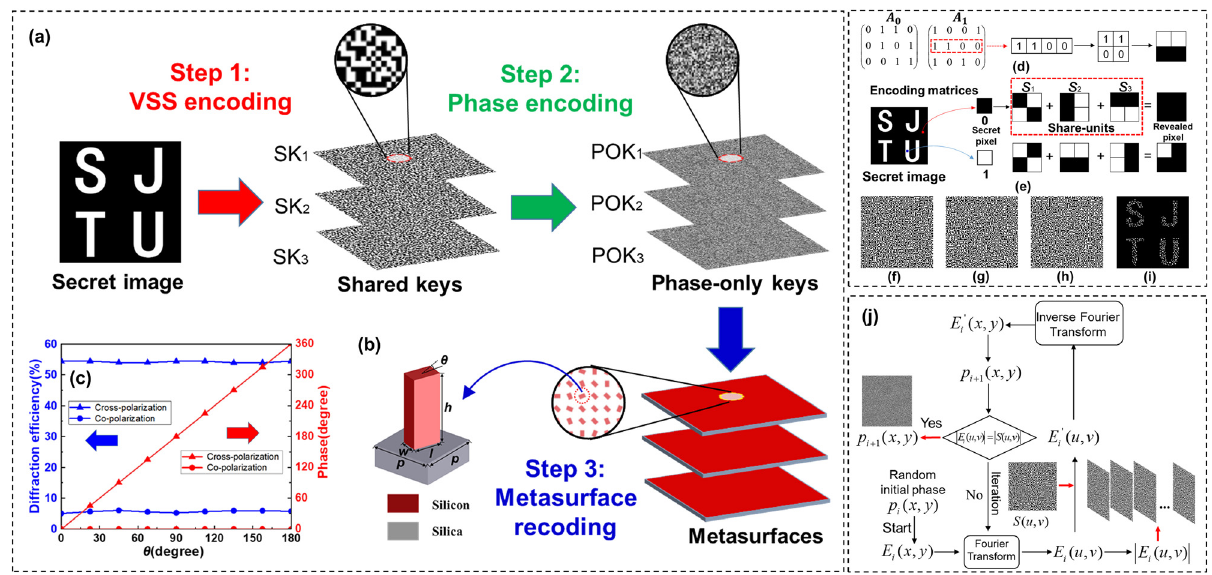
Figure 2: Encryption principle of the proposed SSPE scheme with multiple metasurfaces. (a) Schematic for the corresponding encryption process. (b) Structure unit of metasurface. (c) Simulated diffraction efficiency and phase of the cross-polarized and co-polarized parts. (d – i) The principle of (3, 3) VSS scheme. (j) The flowchart of GS phase retrieval